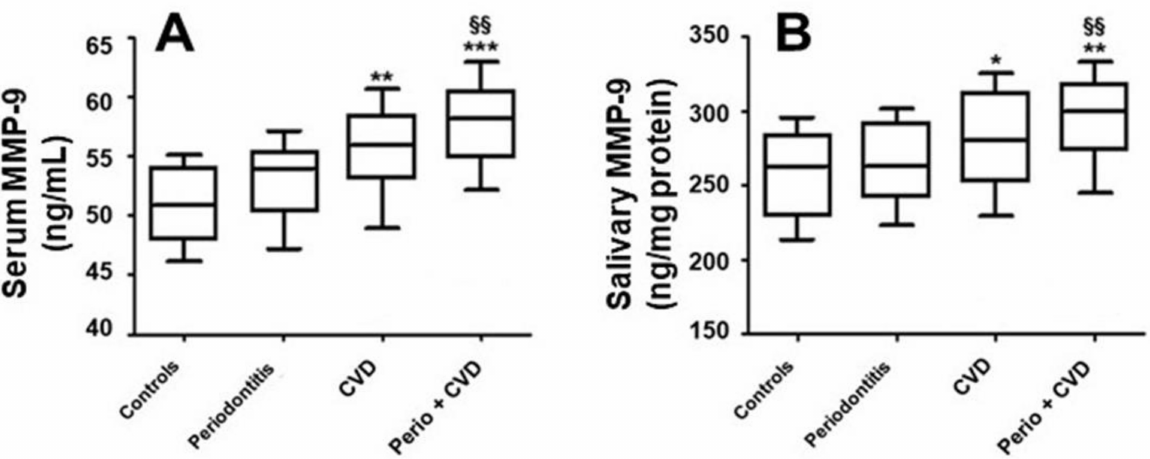
Figure 1. Metalloproteinases-9 (MMP-9) in saliva ( B ) and serum ( A ) (median, 25%; 75% percentiles). §§ p < 0.01 differences vs. periodontitis patients. * p < 0.05, ** p < 0.01, and *** p < 0.001 differences vs. healthy